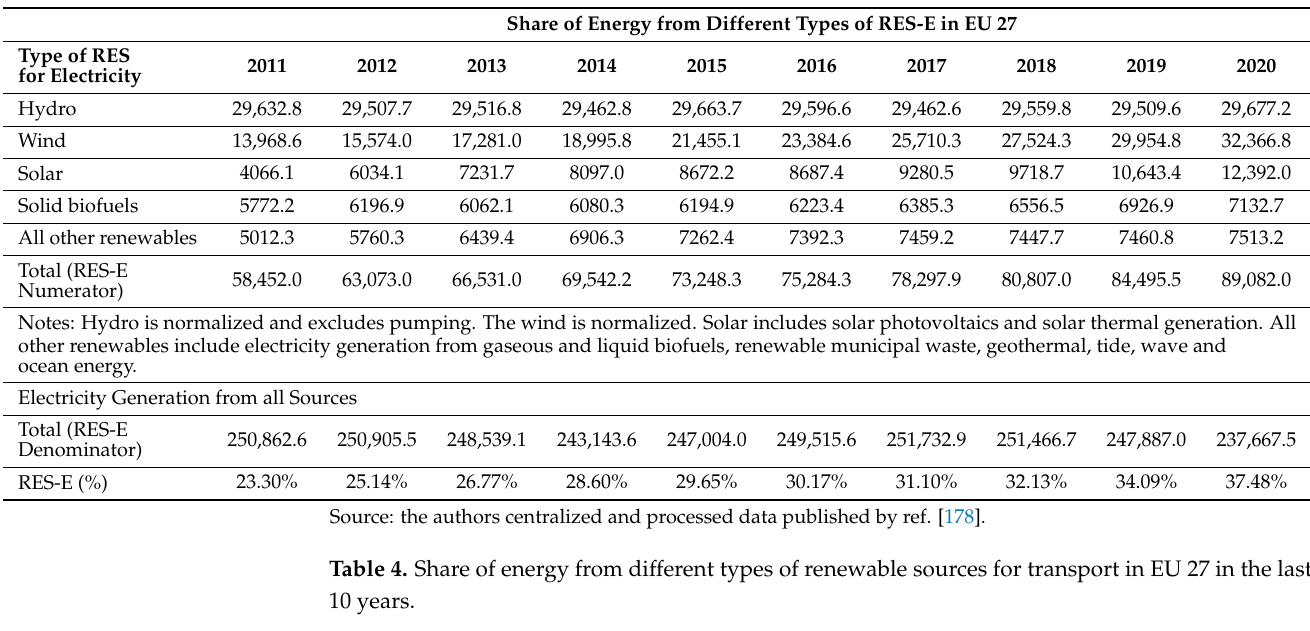
Table 3. Share of energy from different types of renewable sources for electricity in EU 27 in the last 10 years.